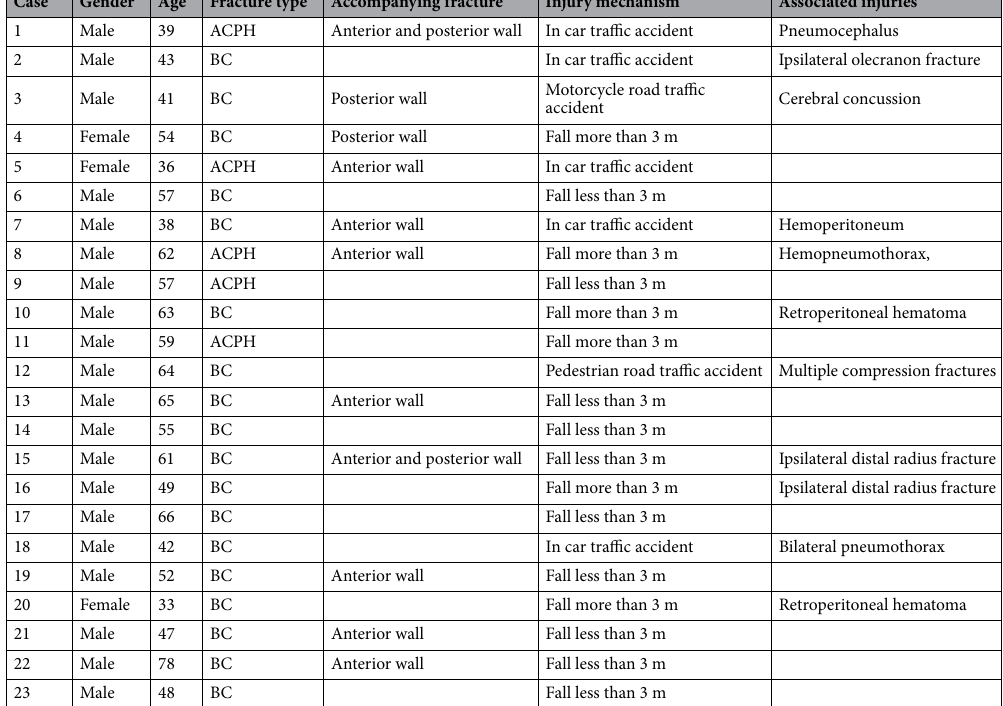
Table 2. Data for 23 patients using a conventional reconstruction plate through modified ilioinguinal approach. BC both column fracture, ACPH anterior column and posterior hemitransverse fracture.